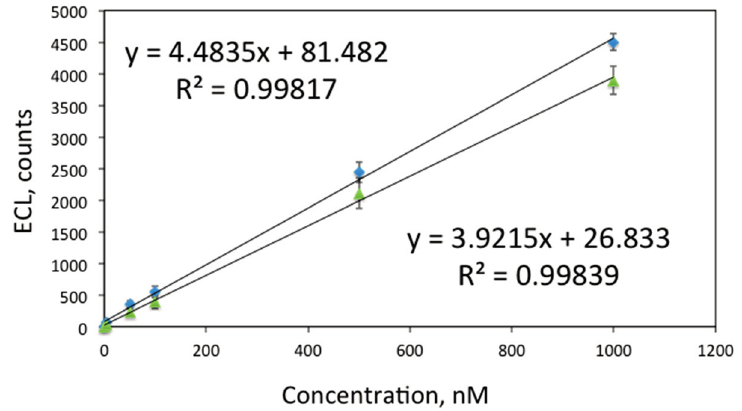
Figure 6. Calibration curves for spermine (diamonds) and spermidine (triangles), measured in 0.1 M phosphate buffer, pH 7.5. Conditions: ECL signal was generated by sweeping potential from 0.8 to 1.3 V vs. an Ag/AgCl reference electrode and recorded with PMT via an optical fibre. Each measurement was done in triplicate with intermediate washing of the sensor.